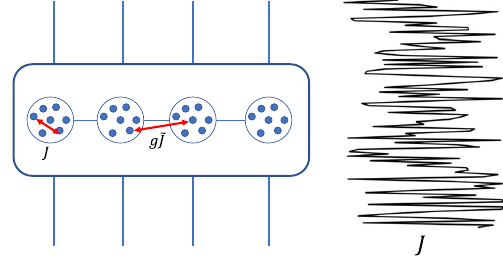
FIG. 1. The Brownian coupled cluster model. Spins within the same cluster interact with each other and also interact with the spins in the neighboring clusters. The intracluster coupling J and ˜ J the intercluster coupling are random in both space and